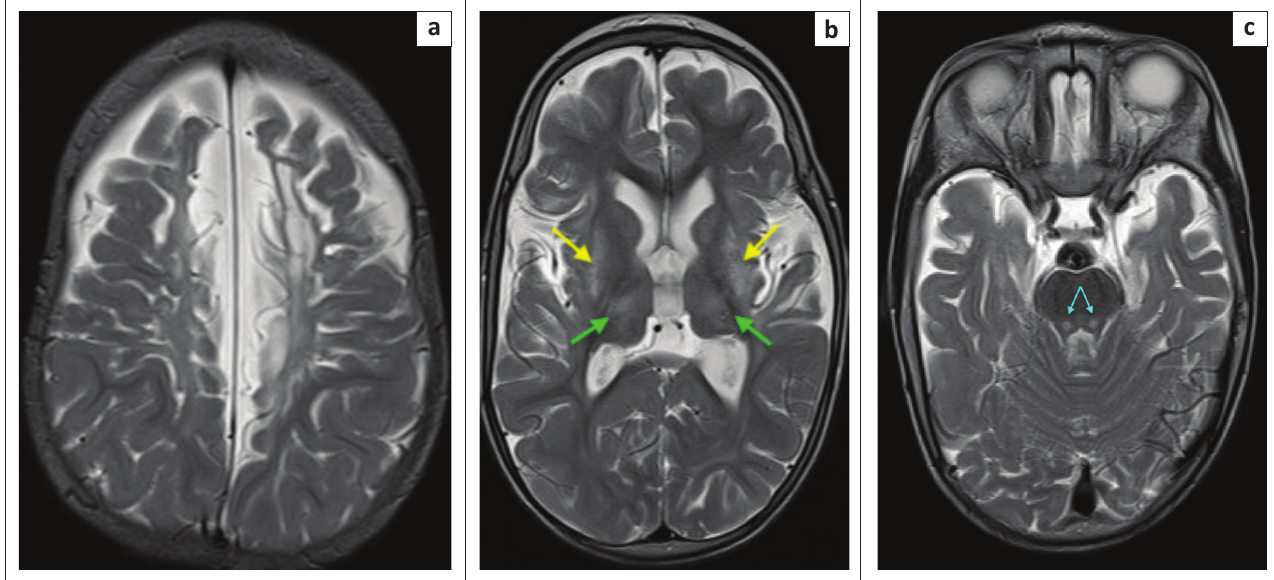
FIGURE 22: A 2-year-old male child with severe mixed type hypoxic ischemic brain injury. T2-weighted axial images (a) at the level of the centrum ovale demonstrating parasagittal frontal lobe injury with atrophy beyond the central sulcus and paracentral lobule, involving the superior frontal gyri with ulegyria, (b) at the level of the basal ganglia shows the hyperintense signal change at the dorsal putamina (yellow arrows) and ventral thalami (green arrows) and (c) at the level of the superior cerebellar peduncles reveals prominent central tegmental tract (cyan blue arrows) hyperintensity at the dorsum of the